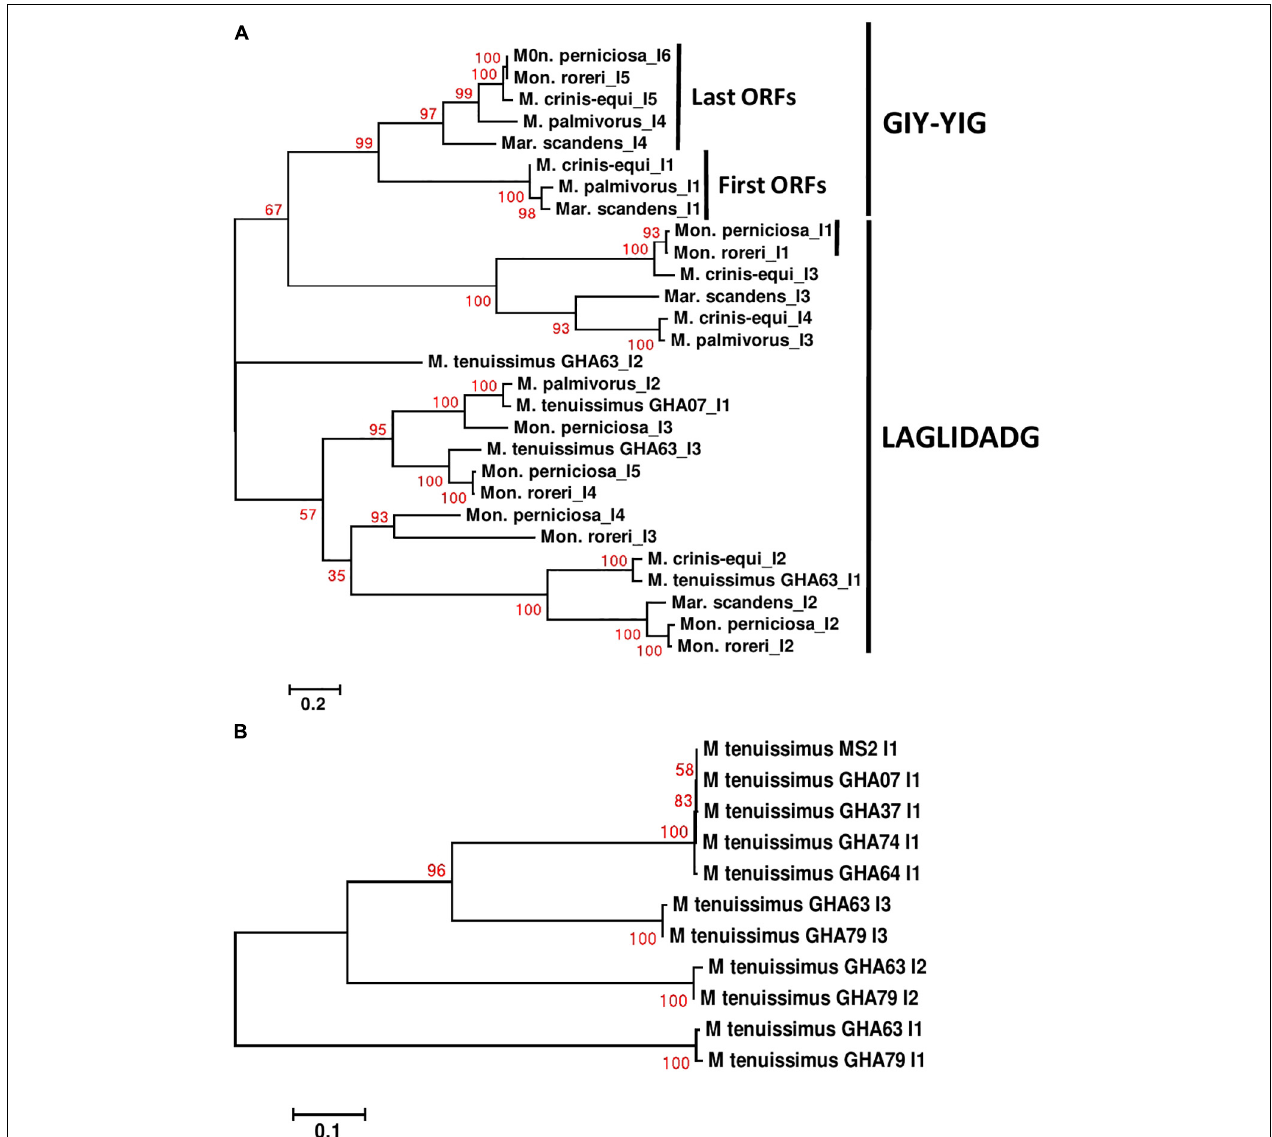
FIGURE 6 | Molecular phylogenetic analysis of cox1 introns of four cacao thread blight associated pathogens from Ghana ( M. tenuissimus , M. palmivorus , M. crinis-equi , Mar. scandens ) and the Western hemisphere frosty pod rot ( Mon. roreri ) and witches’ broom ( Mon. perniciosa ) pathogens of cacao. The analysis was based on nucleotide sequences of cox 1 introns from each isolate with 1,566 distinct alignment positions and 1,000 rapid bootstrap inferences. (A) Two M. tenuissimus isolates with other five species. (B) Seven isolates of M. tenuissimus . Sequences were combined and aligned using ClustalW2 tool under default setting and the phylogenetic tree was reconstructed using the Maximum Likelihood method. The tree is drawn to scale, with branch lengths measured in the number of substitutions per site. Analyses were conducted in MEGA6 (Tamura et al.,